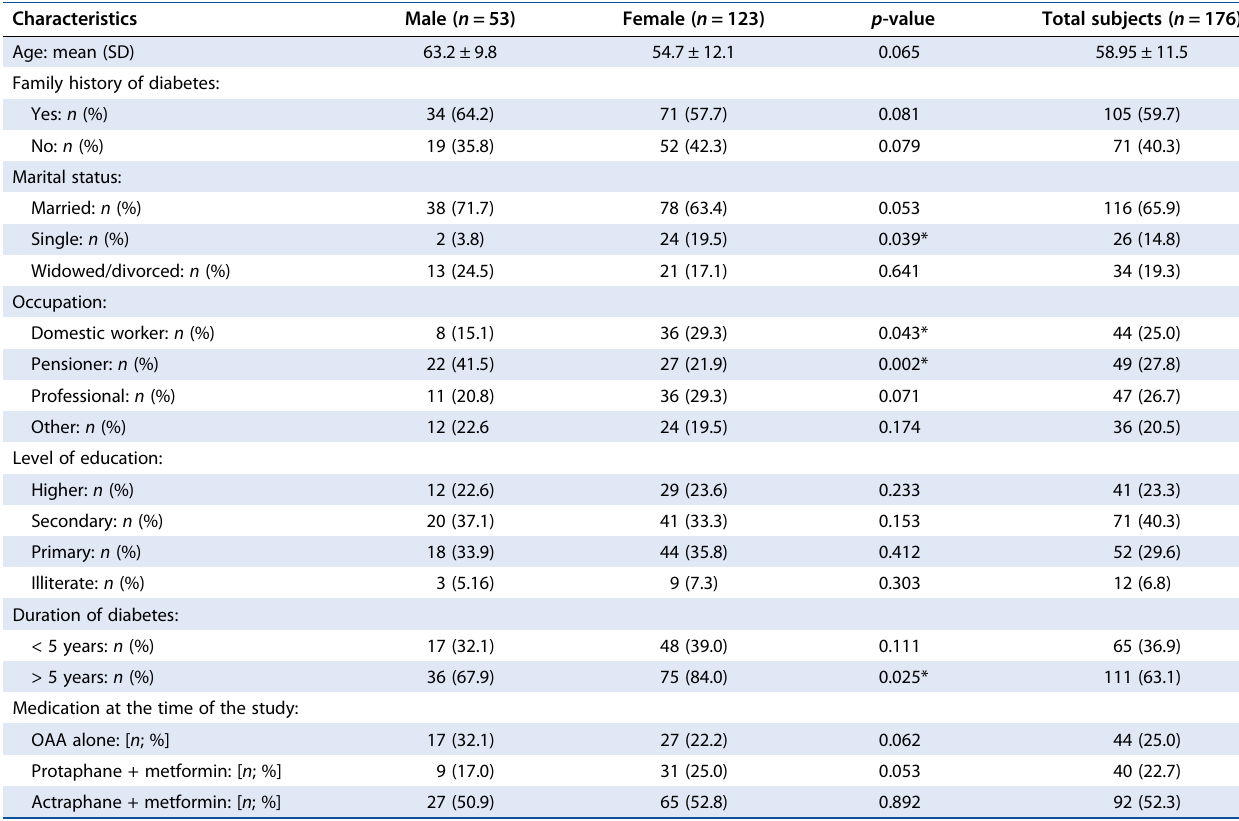
Table 1: Demographic, selected socioeconomic and selected clinical characteristics of the study subjects stratified by gender